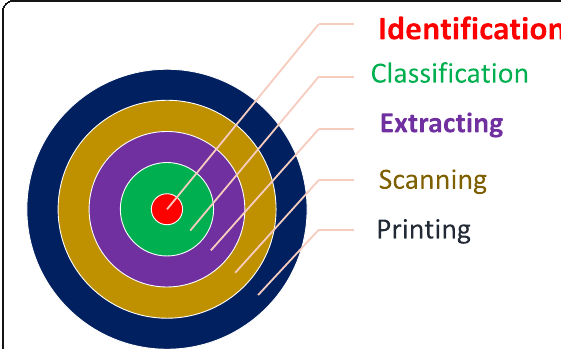
Fig. 1 The five defined steps for determination the identity and uniqueness of the candidate color laser printouts